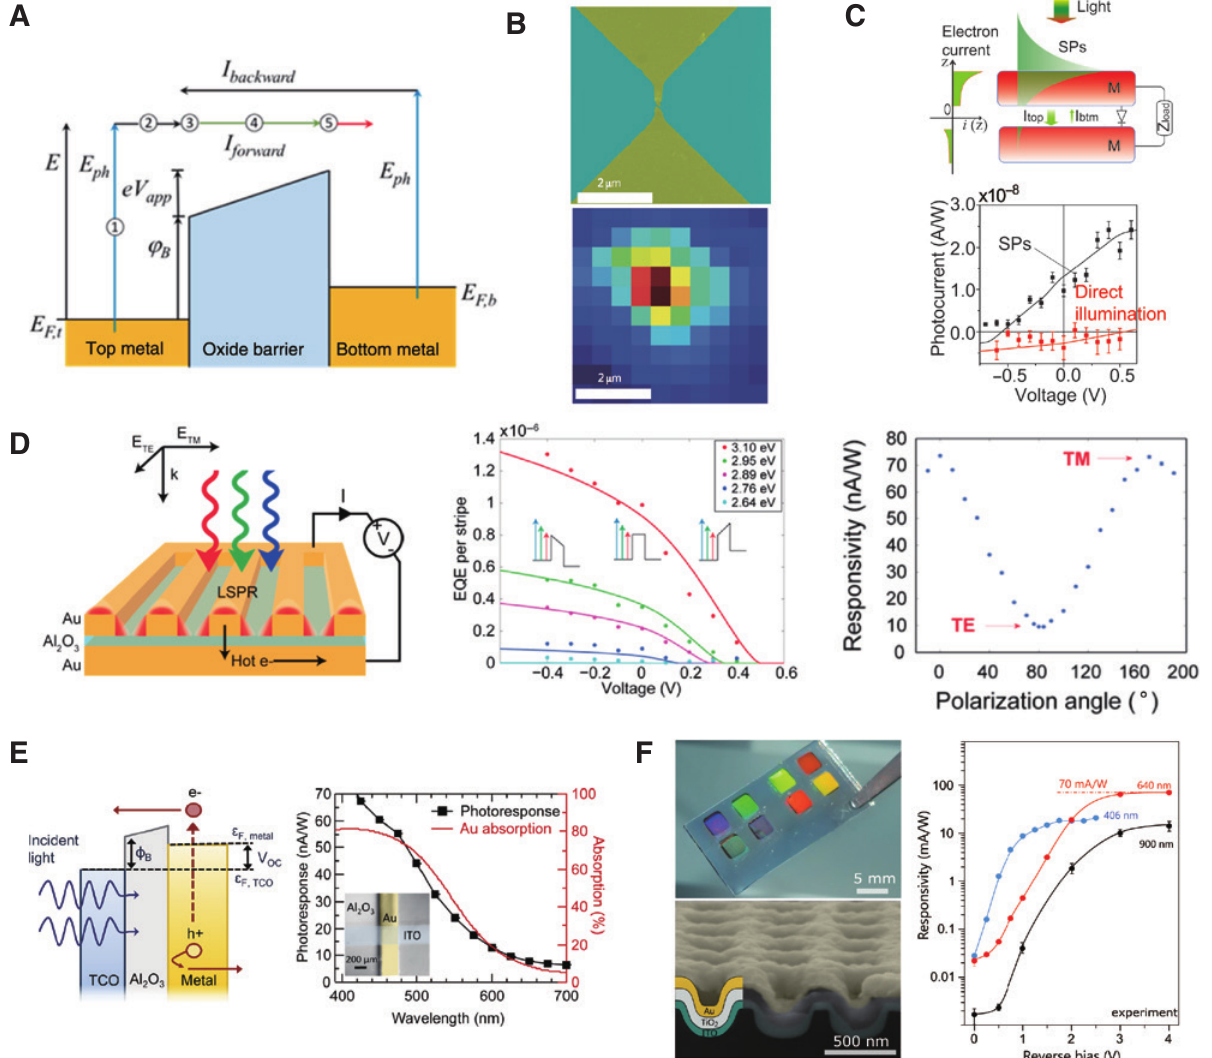
Figure 3: Free-space hot electron photodetectors based on MIM and metal-insulator-TCO junctions. (A) Band diagram for a metal-insulator-metal diode. Hot electrons can be generated in either contact and get collected through five consecutive steps. (B) Colorized SEM image (top) and photocurrent map (bottom) of a plasmonic nanogap antenna. Electrons can tunnel through the nanogap and generate photocurrent. (C) Top: Schematic of the MIM device. With a hot electron density difference in the